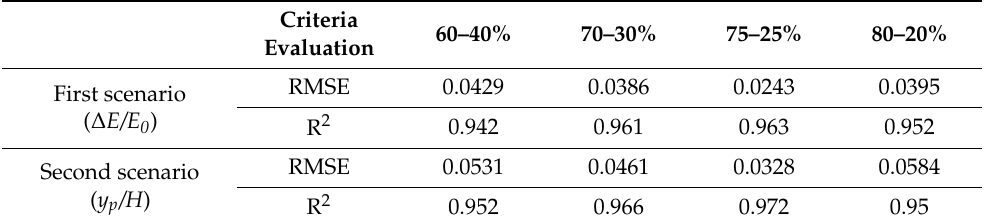
Table 3. Criteria for evaluating different percentages of training and testing in general (training–testing).